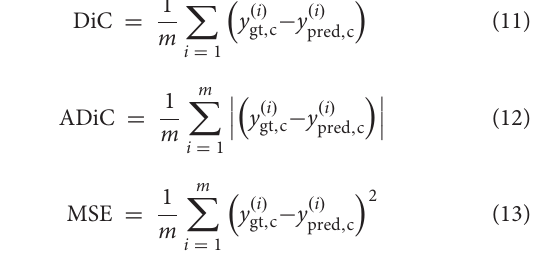
Frontiers in Plant Science |